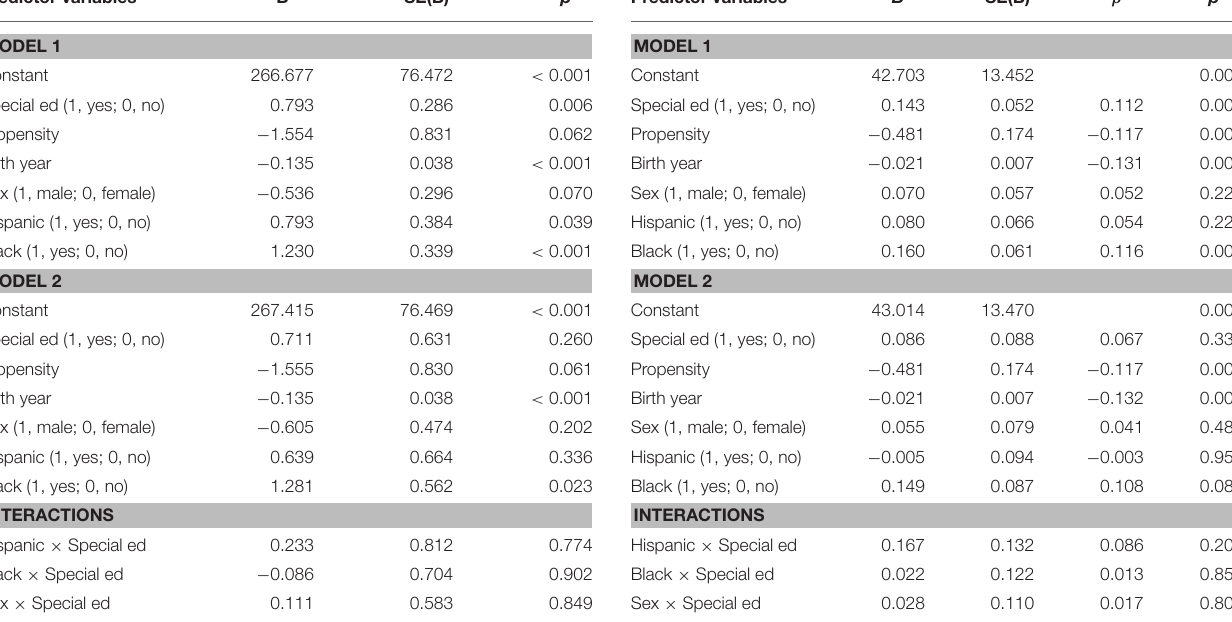
TABLE 7 | Hierarchical multiple regression analyses predicting years of welfare use ( n = 586). Predictor